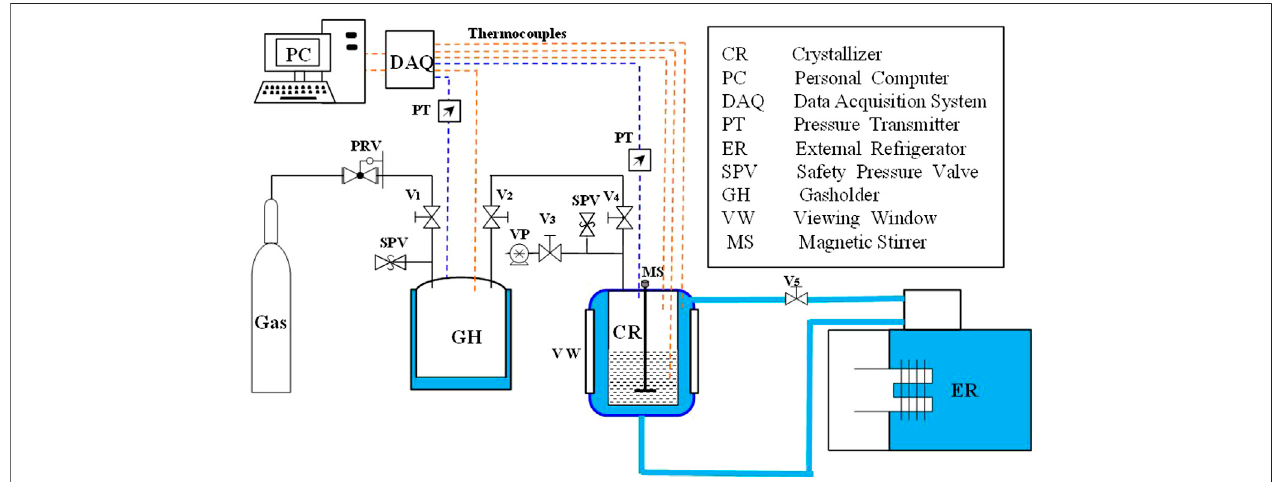
FIGURE 1 | Diagram of the setup for the CO 2 hydration